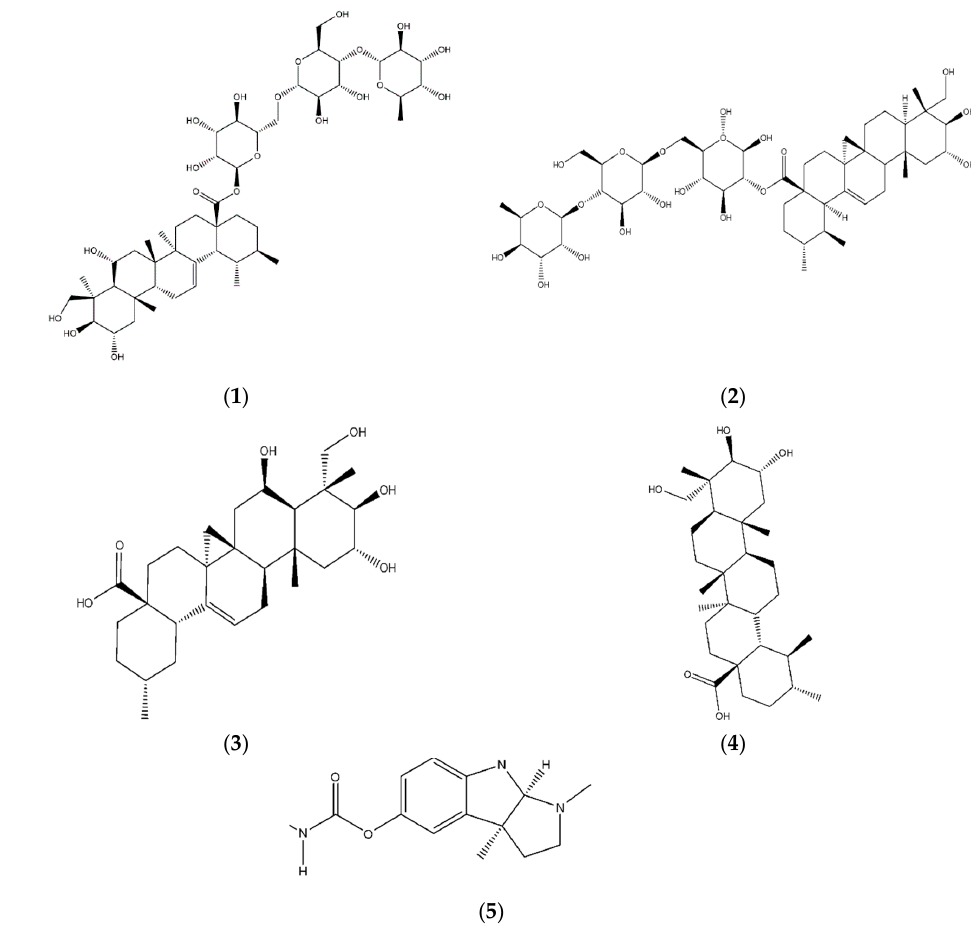
Figure 1. Triterpenes identified in Centella asiatica (L.) Urban (CA) ( 1 ) madecassoside; ( 2 ) asiaticoside; ( 3 ) madecassic acid; ( 4 ) asiatic acid; ( 5 ) eserine.